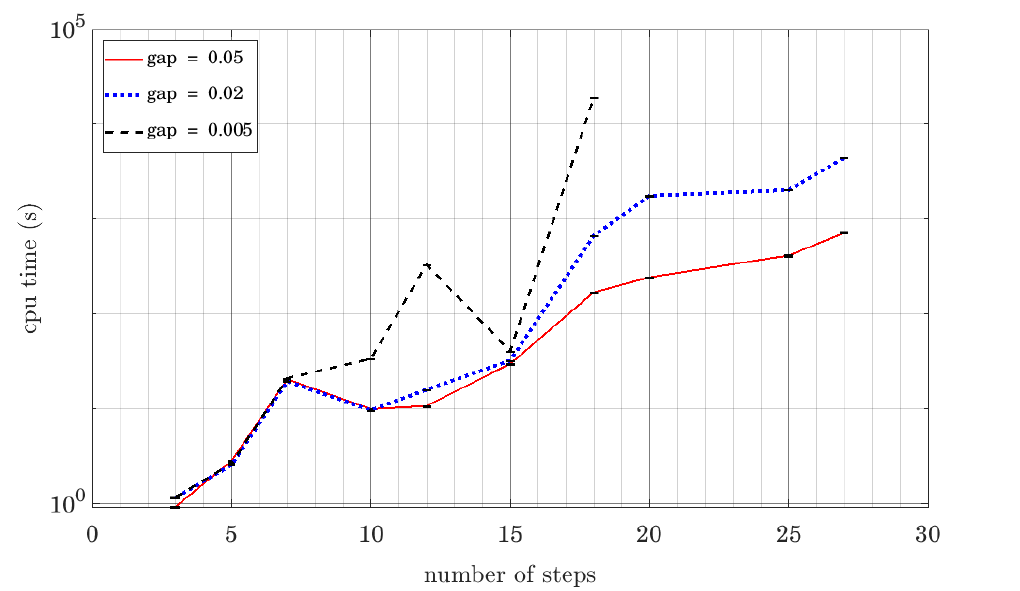
Figure 4. CPU time as a function of the number of steps, calculated for Gurobi gap values 0.05, 0.02 and 0.005; vertical axis is given in logarithmic scale.